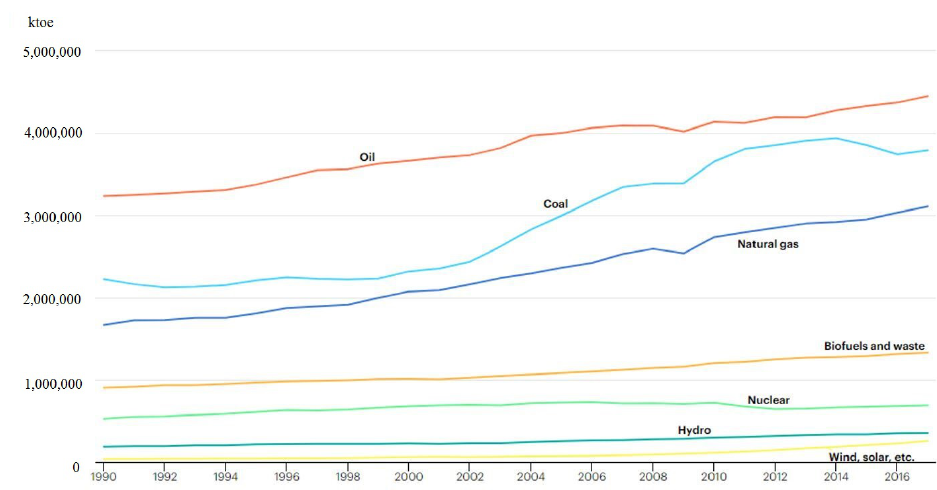
Figure 1. Total Primary Energy Supply (TPES), by Source, Global 1990–2017. Source: International Energy Agency